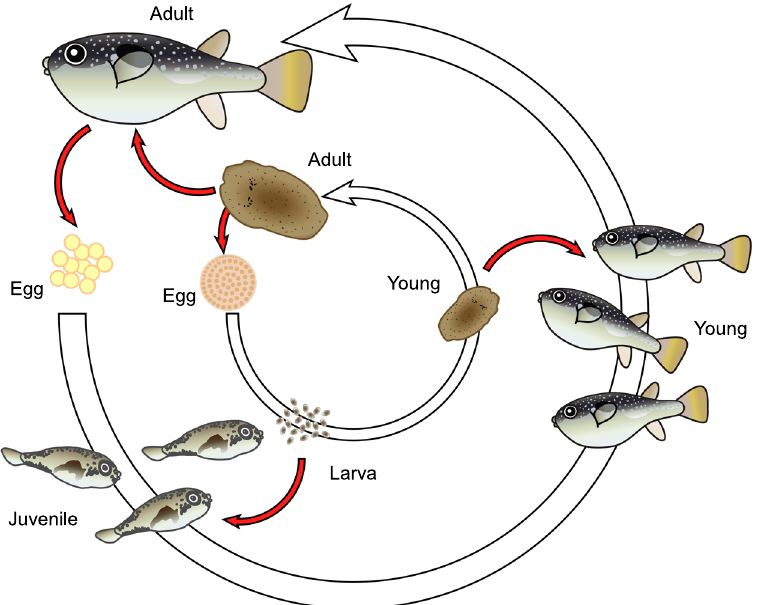
Figure 5. Role of the toxic flatworm Planocera multitentaculata in the toxification of the pufferfish Takifugu niphobles throughout its life cycle. Red arrows indicate transfer of